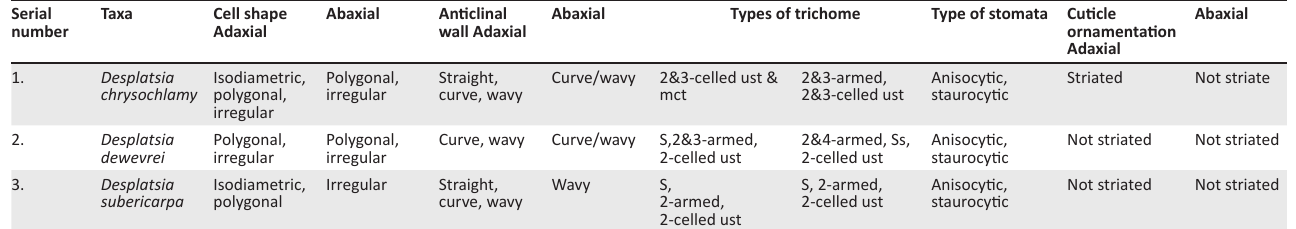
TABLE 2: Qualitative leaf epidermal characters of some Desplatsia species in West Africa. Serial number